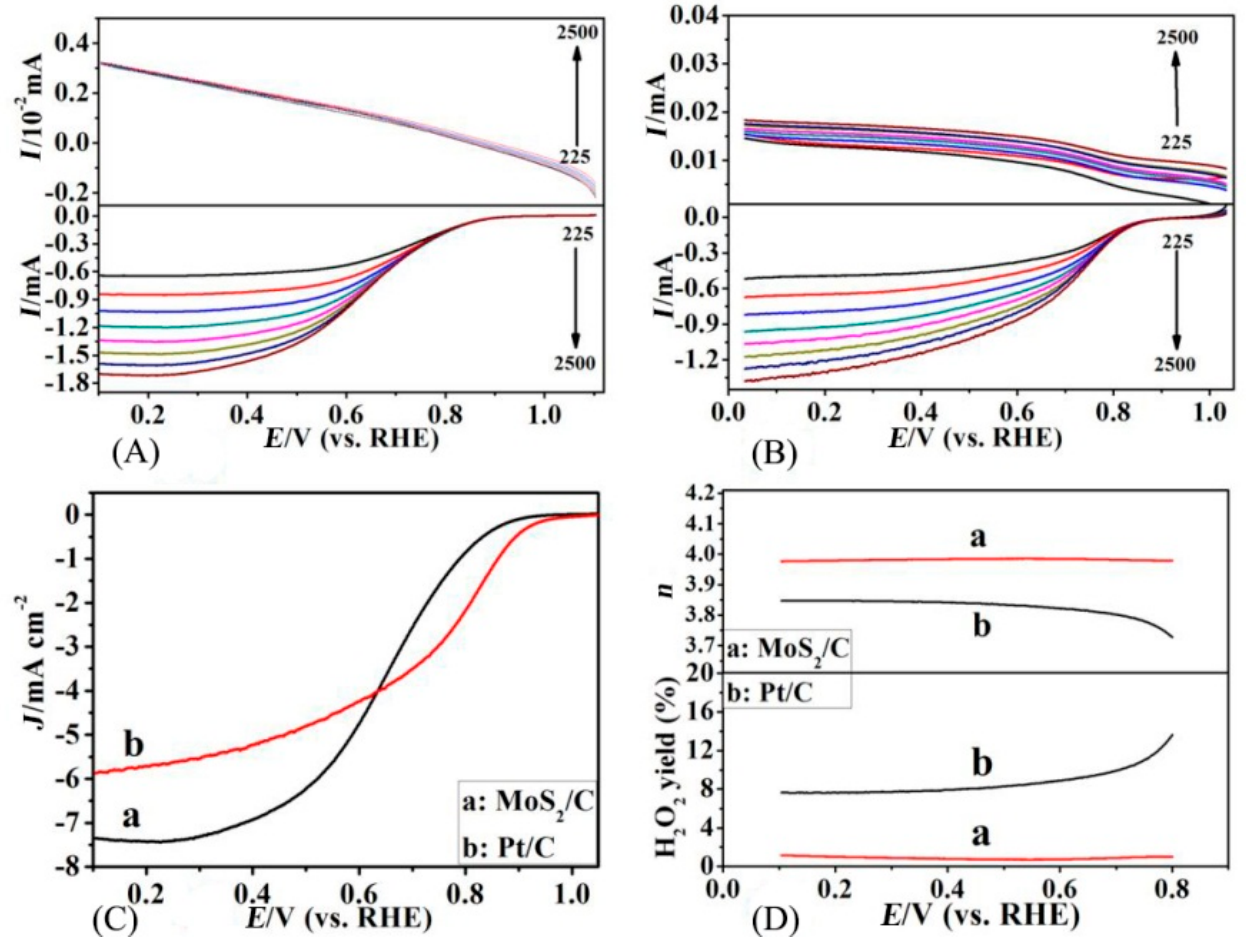
Figure 8. RRDE plots of different modified electrode: ( A ) MoS 2 /C-25, ( B ) Pt/C at different rotation rate; ( C ) LSV curves of the MoS 2 /C -25 ( a ) and Pt/C ( b ) in O 2 -saturated 0.1 M HClO 4 solution at rotation rate of 1600 rpm; ( D ) H 2 O 2 yield measured and electron transfer number (n) using ( a ) MoS 2 /C-25 and ( b ) Pt/C as a catalyst, respectively, in O 2 -saturated 0.1 M HClO 4 with rotation rate of 1600 rpm. Scan rate: 10 mVs − 1 .